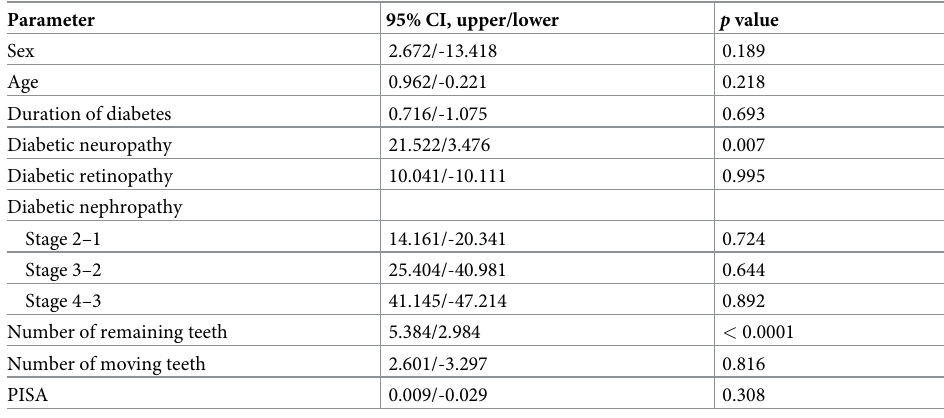
Table 2. Multivariable